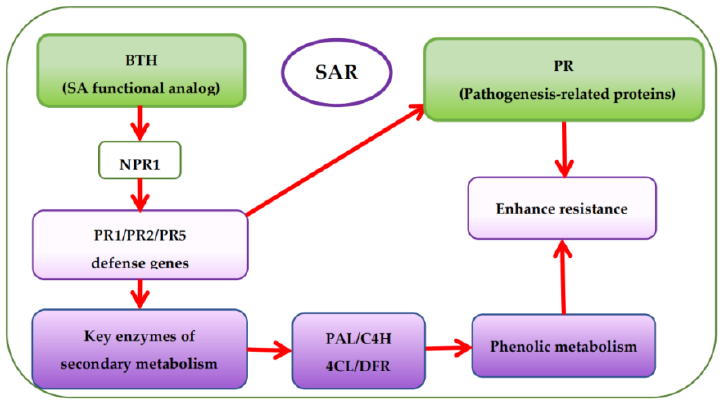
Figure 5. Overview of systemic acquired resistance (SAR) and phenolic accumulation mechanism with BTH treatment.